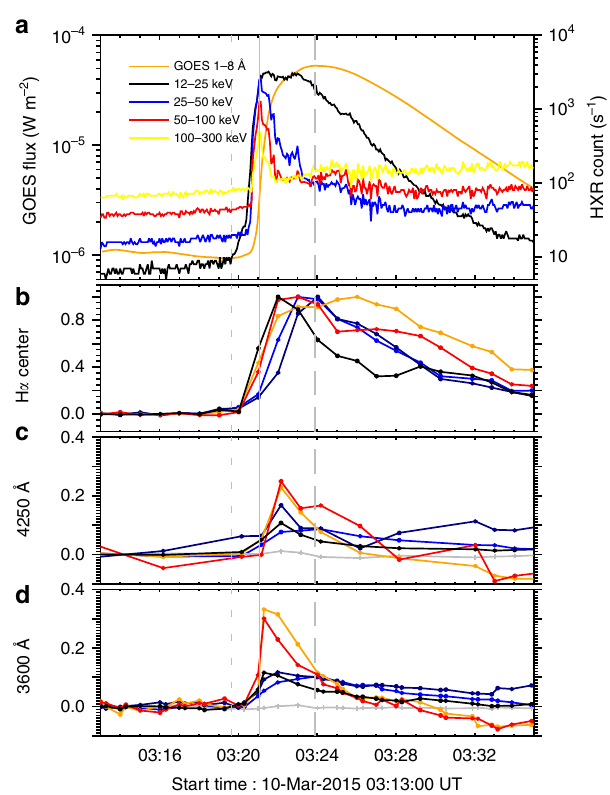
Fig. 3 Light curves of the fl are at different wavebands. a The GOES SXR 1 – 8 Å fl ux (orange) and the RHESSI HXR counts at 12 – 25 keV (black), 25 – 50 keV (blue), 50 – 100 keV (red), and 100 – 300 keV (yellow) for the white-light fl are. b – d Relative enhancements (contrasts) at H α line center, 4250, and 3600 Å for the areas where the white-light emission appears. The colors of the curves correspond to the colors of the arrows in Fig. 1b. The short dashed vertical lines show the onset time of the SXR fl ux, the solid vertical lines show the peak time of the HXR fl ux, and the long dashed vertical lines show the peak time of the SXR fl ux. The gray lines with plus signs in c , d show the continuum contrast of a plage near the fl are site at 4250 and 3600Å, respectively